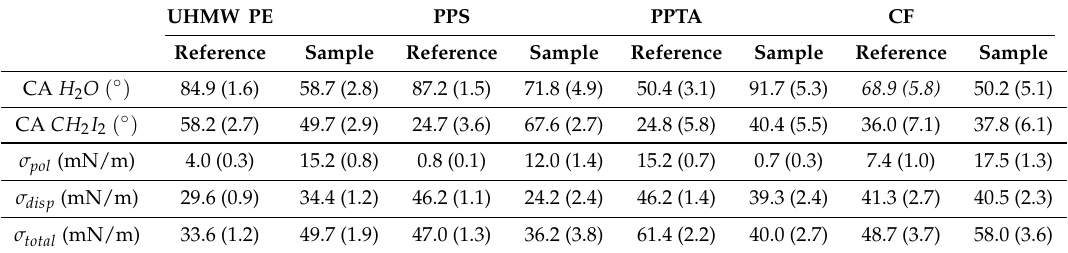
Table 1. Contact angles (CA) and polar and disperse parts of surface energies ( σ ) before and after (oxy-)fluorination of the investigated high-performance fibers (standard deviation in parenthesis). All high-performance fibers were prepared with Recipe 2, except CF (Recipe